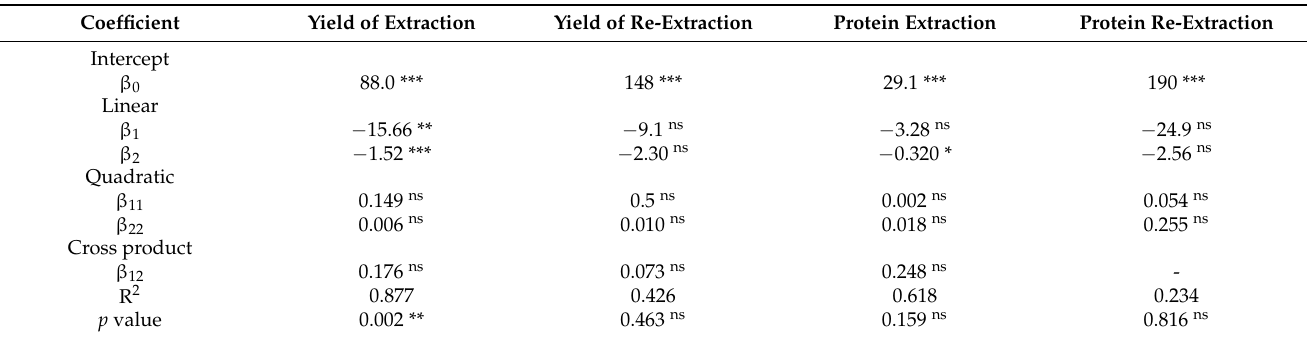
Table 3. Regression coefficients of the predicted second-order polynomial models for the investigated responses from agar extracted by conventional extraction.